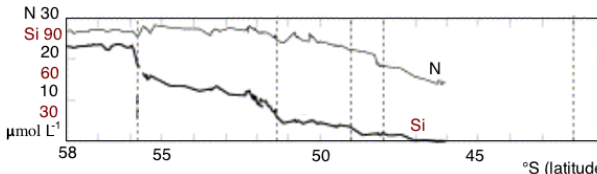
Figure 1. Nitrate and silicate concentration in the surface layer ob- served during a German SO JGOFS cruise along 5 ◦ E. Figure mod- ified from Pollard et al.